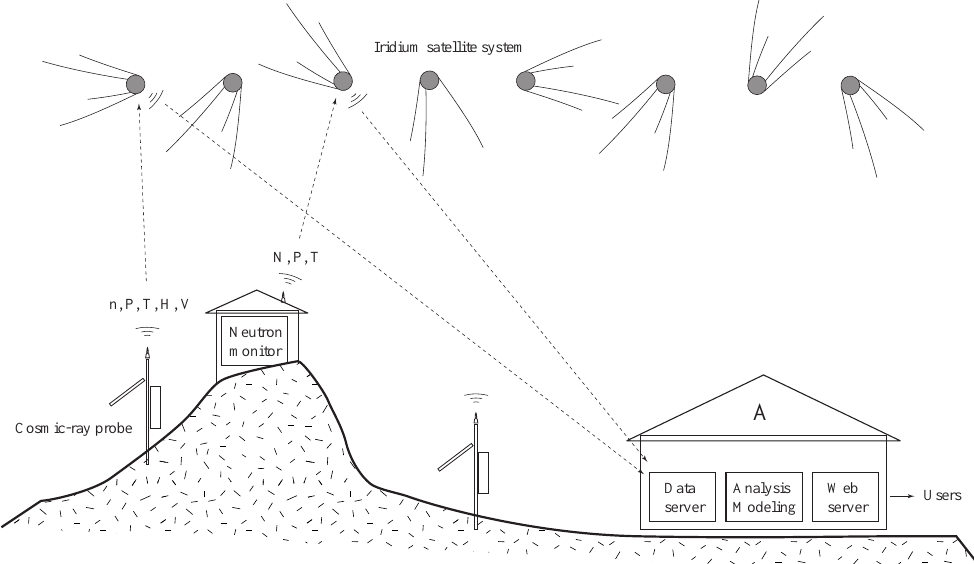
Fig. 10. The COSMOS consists of cosmic-ray probes that measure fast and thermal neutrons; neutron monitors that measure high-energy neutrons; a data transmission system (using Iridium satellite constellation); and computers for data acquisition and processing, analysis and modeling, and data and information dissemination. Key to abbreviations: n =fast neutron count rate; P =atmospheric pressure; T =air temperature; H =relative humidity; V =battery voltage; N =high-energy neutron count rate; A stands for Arizona where the COSMOS servers are